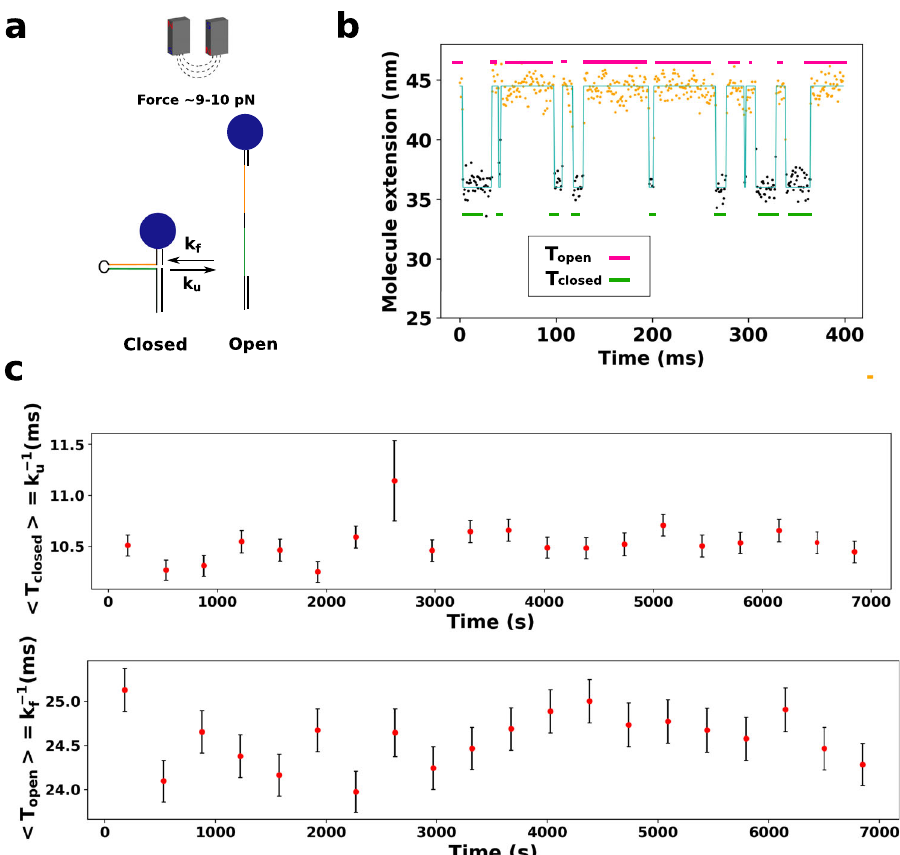
Fig. 1 Kinetic rates of a DNA hairpin pulled with magnetic tweezers are stable during several hours. a A force is applied to the hairpin with magnetic tweezers, allowing the latter to reach a state where it oscillates between its ssDNA and dsDNA con fi gurations. b Measured extension of the hairpin as a function of time. Dots represent raw data. The blue line and the dot colors represent the inferred state. T open and T closed are de fi ned as the time spent in the open and closed states by the hairpin. c Average T closed and T open measured during 7000 s of acquisition of the extension of a single molecule. The average is performed over time bins of 350 s. Error bars are calculated through bootstrap